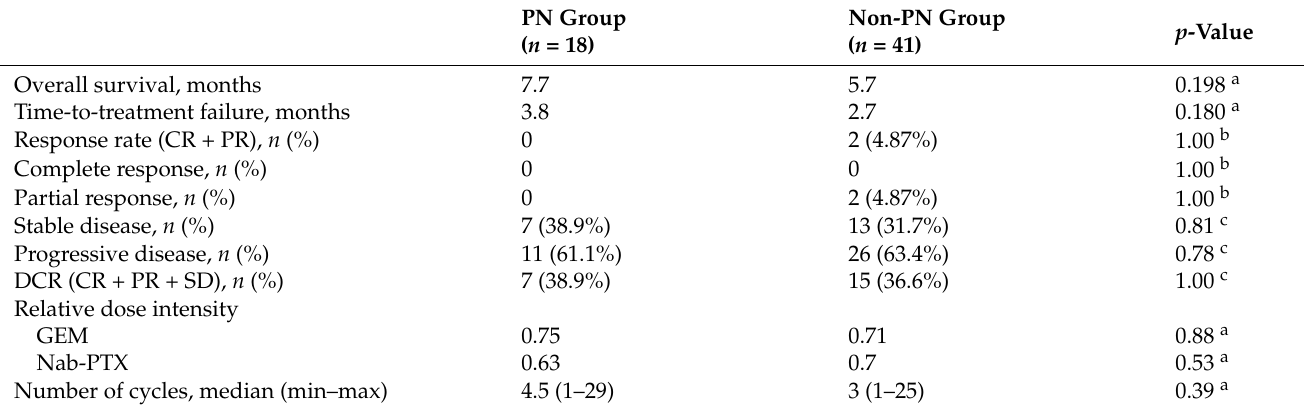
Table 2. Comparison of tumor response, relative dose intensity, and the number of cycles.